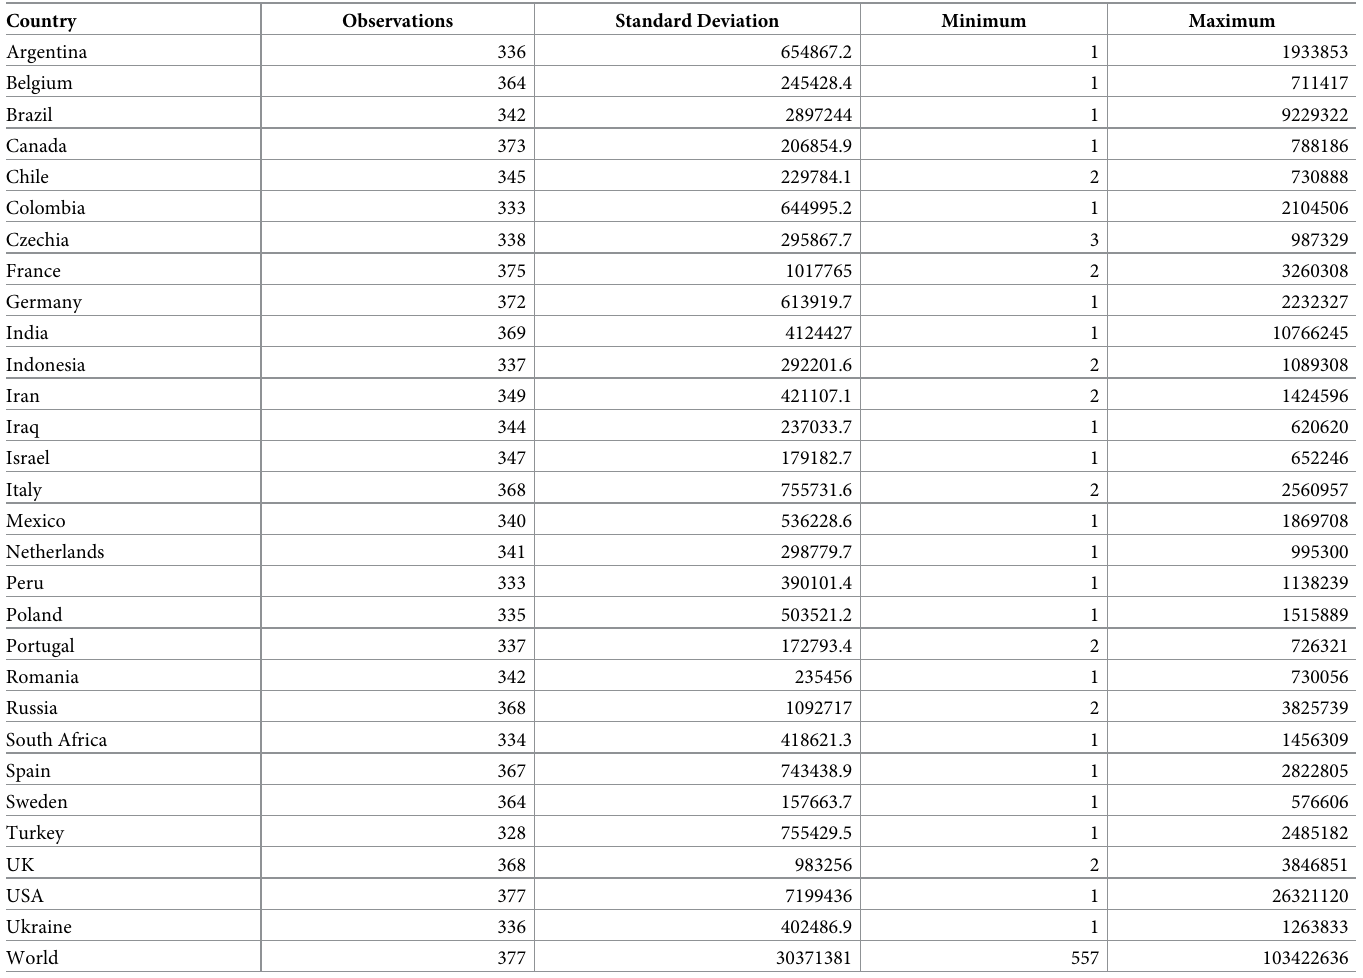
Table 1. Descriptive statistics of the 29 countries with the highest cumulative COVID-19 cases and at the aggregated level of the entire world.